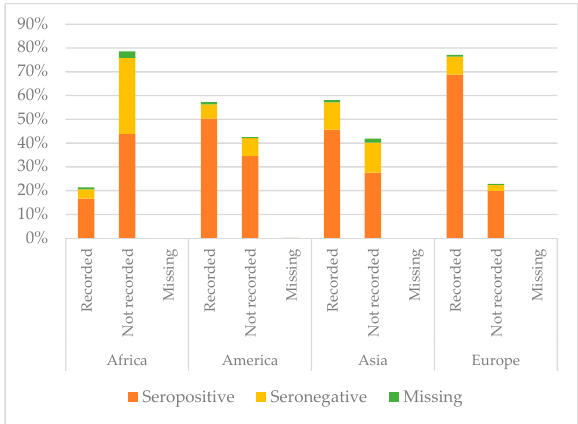
Figure 5. Comparison between immunisation status of IAC reported in the documentation and serology for diphtheria, by continent of origin (Table A2 in the Appendix).